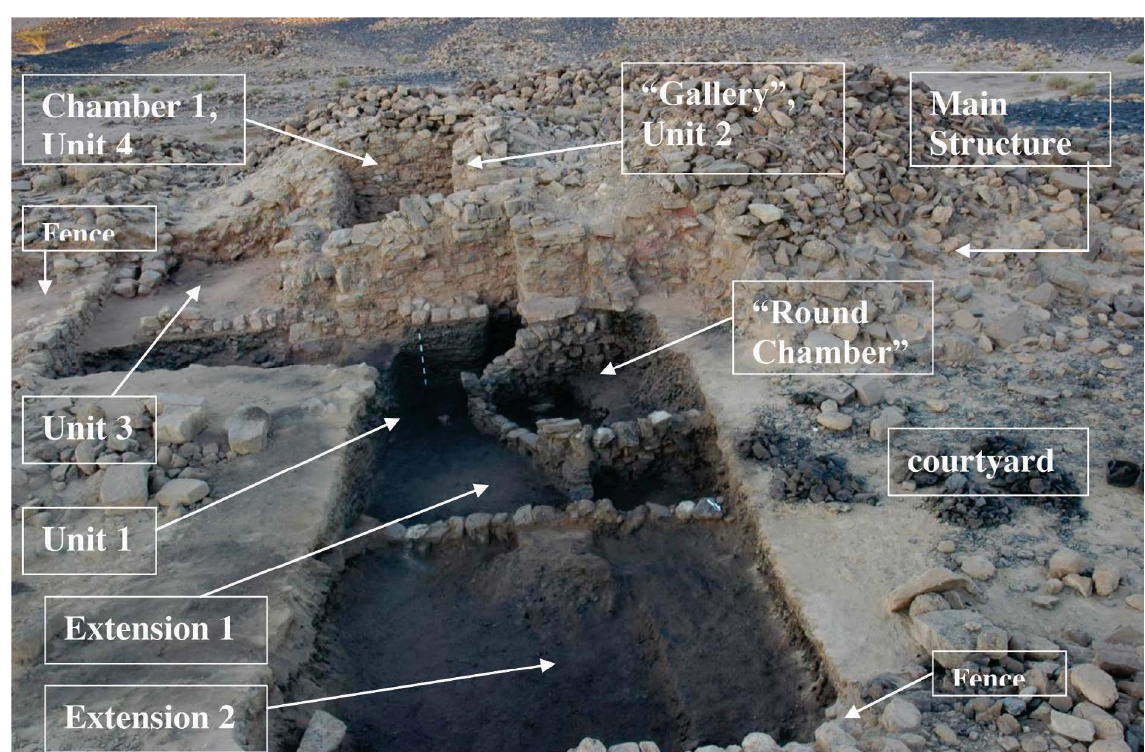
Figure 8. 2006 Khirbat en-Nahas excavation - Area R. (Source: Levy et al.